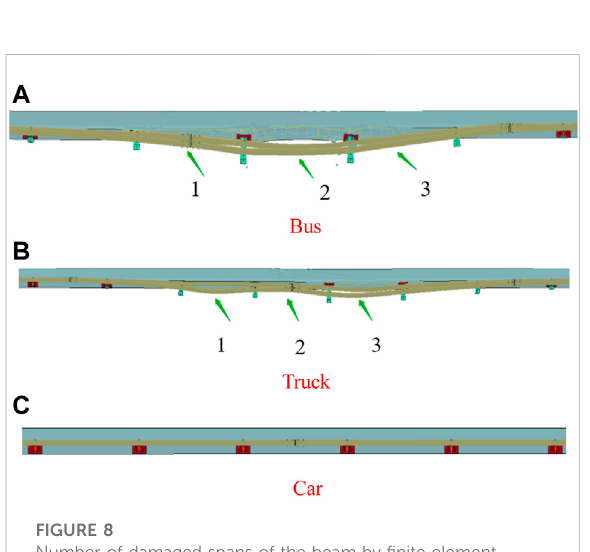
FIGURE 8 Number of damaged spans of the beam by fi nite element simulation. (A) Bus. (B) Truck. (C) Car.